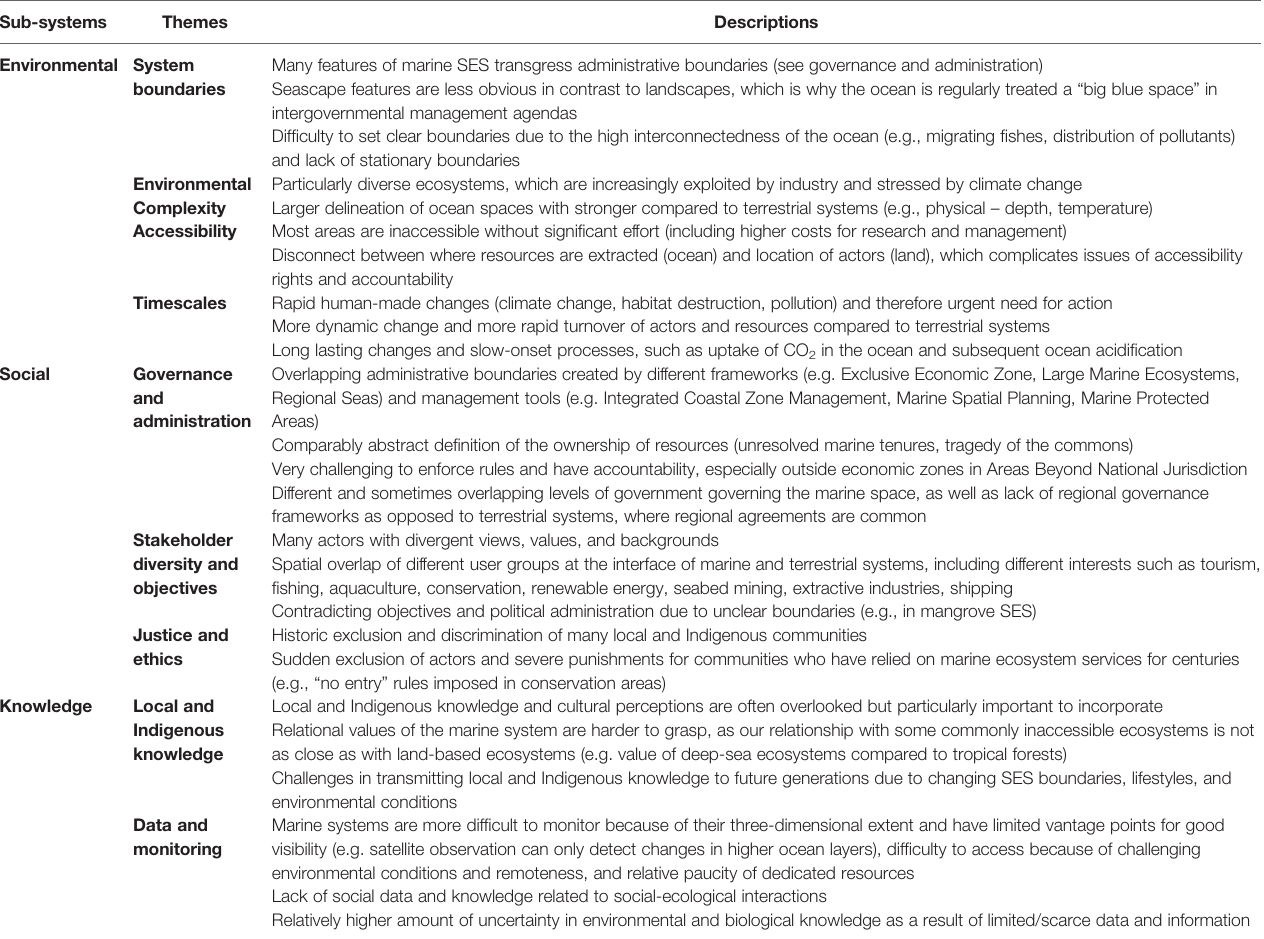
quotation marks are citations from the survey and a full list of obstacles including ratings by the survey participants can be found in the Supplementary Material (Table S1)